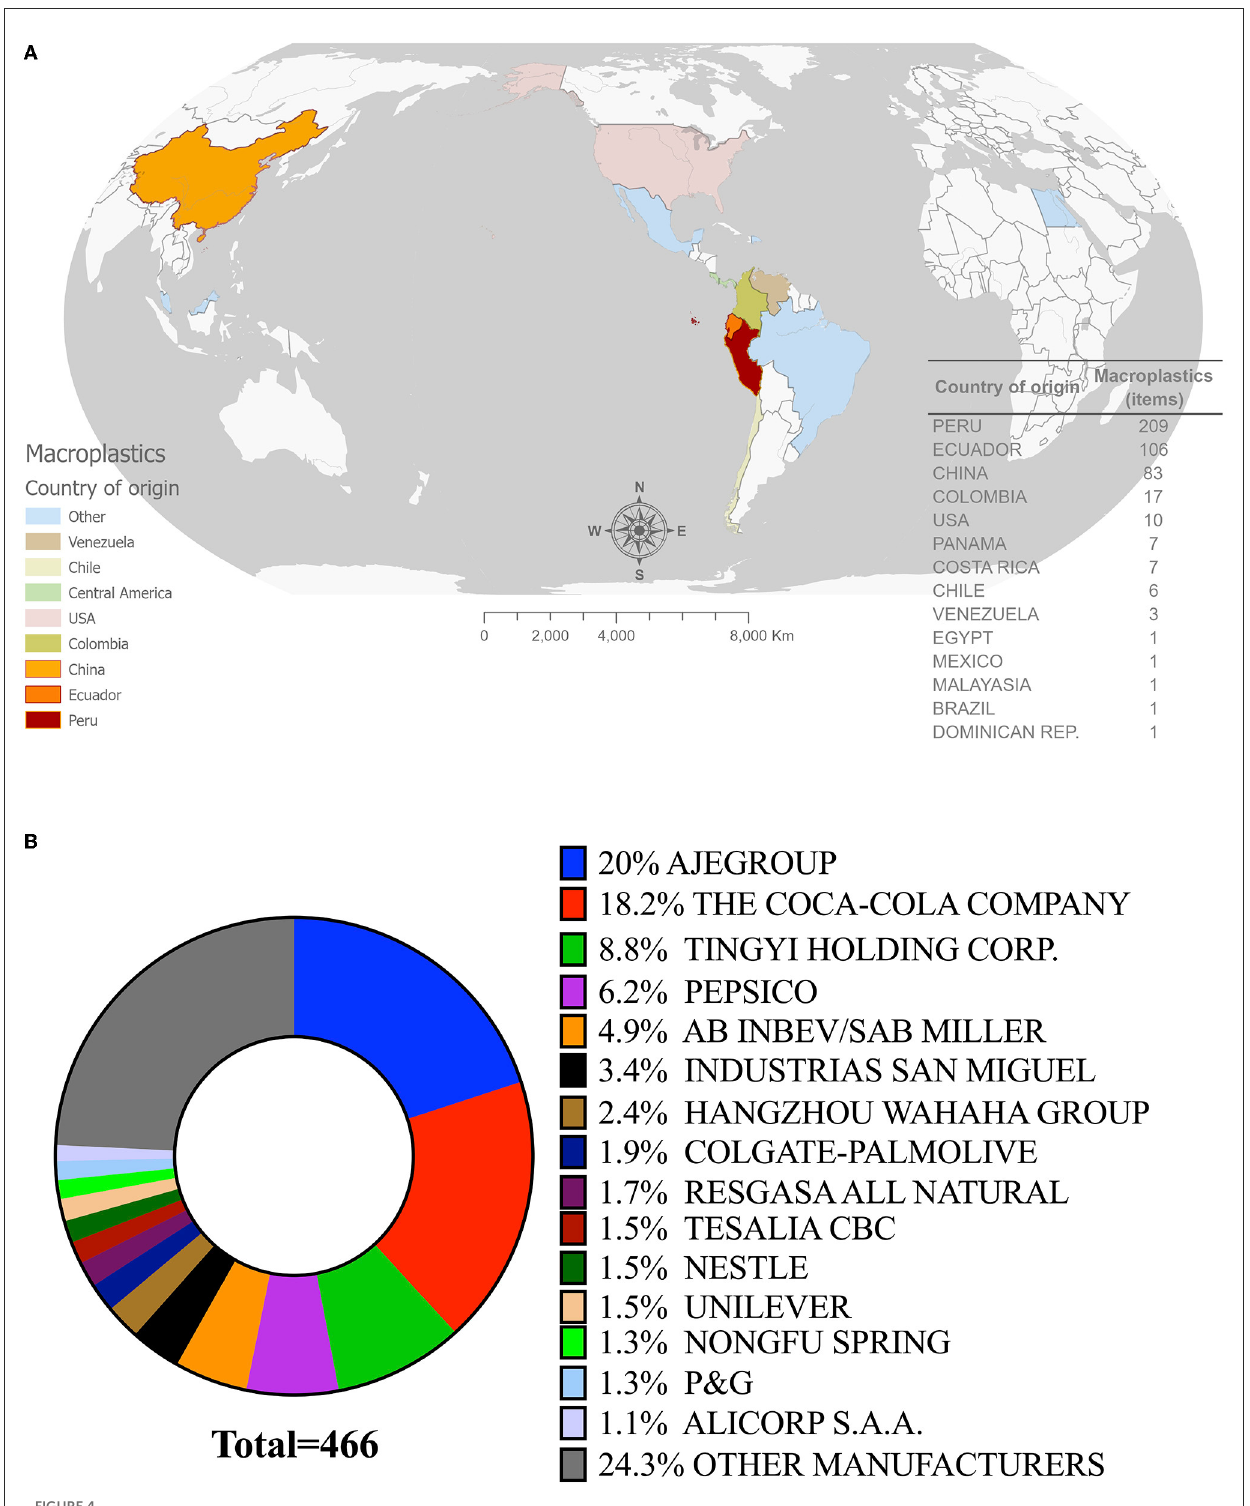
FIGURE4 (A) Countries of origin of the examined macroplastics. Country of origin was identified from a random subsample of 466 items with a potential identifier (legible inscriptions, stamps, or labels) from all transects/locations in this study. A potential identifier was used to perform the search using Google Lens. Google Lens was a way to collect data on items with inscriptions in languages unknown to us, such as Mandarin. Countries with stronger colors: more items from that country were found. (B) The 15 top manufacturers of examined